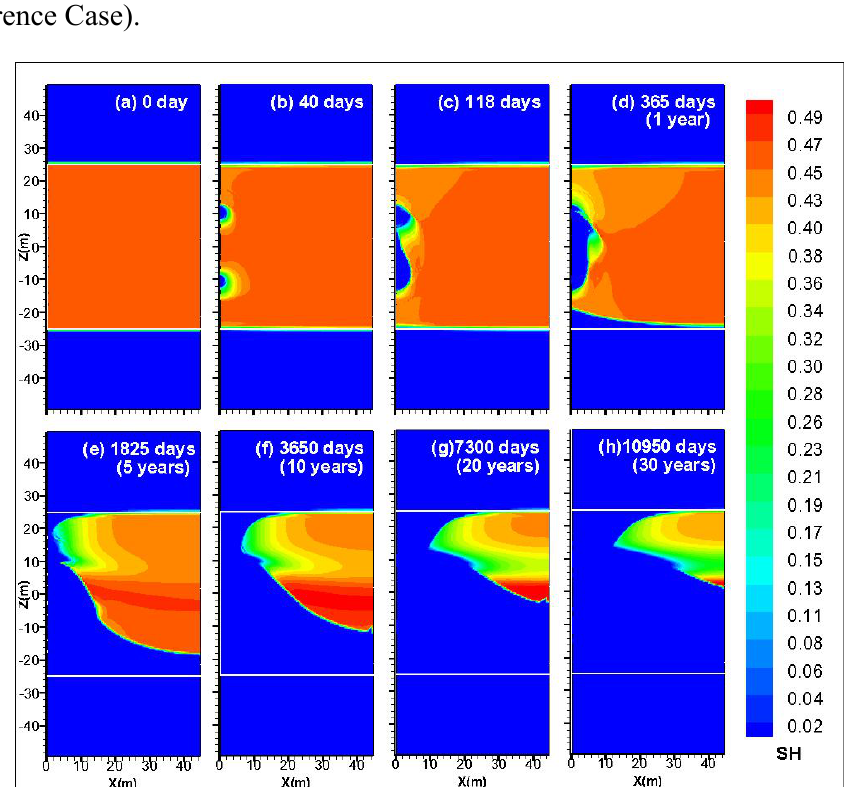
during hydrate dissociation H